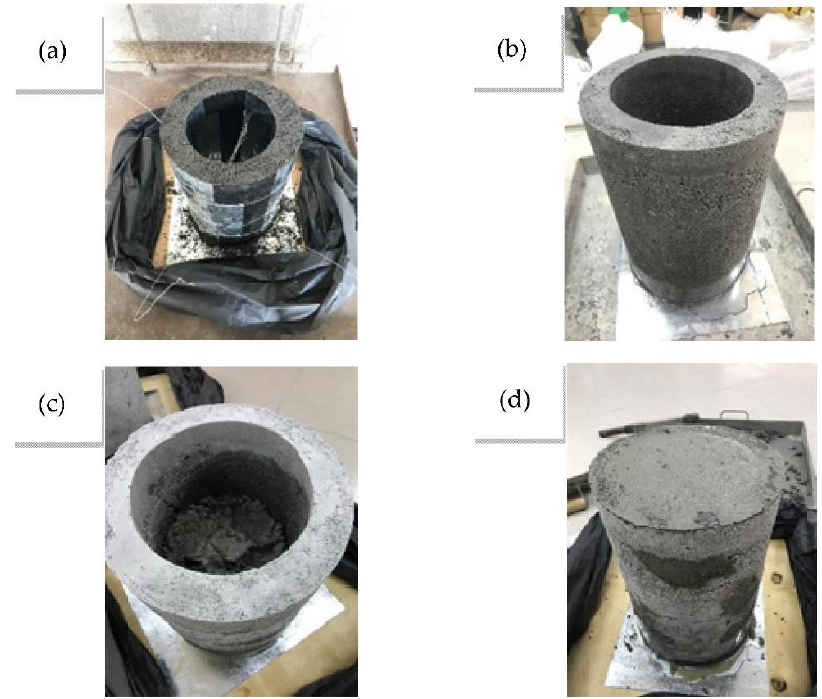
Figure 3. Tube fabrication procedure. ( a ) Tube pouring; ( b ) Surface drying; ( c ) Core concrete pouring; ( d ) Core capping.